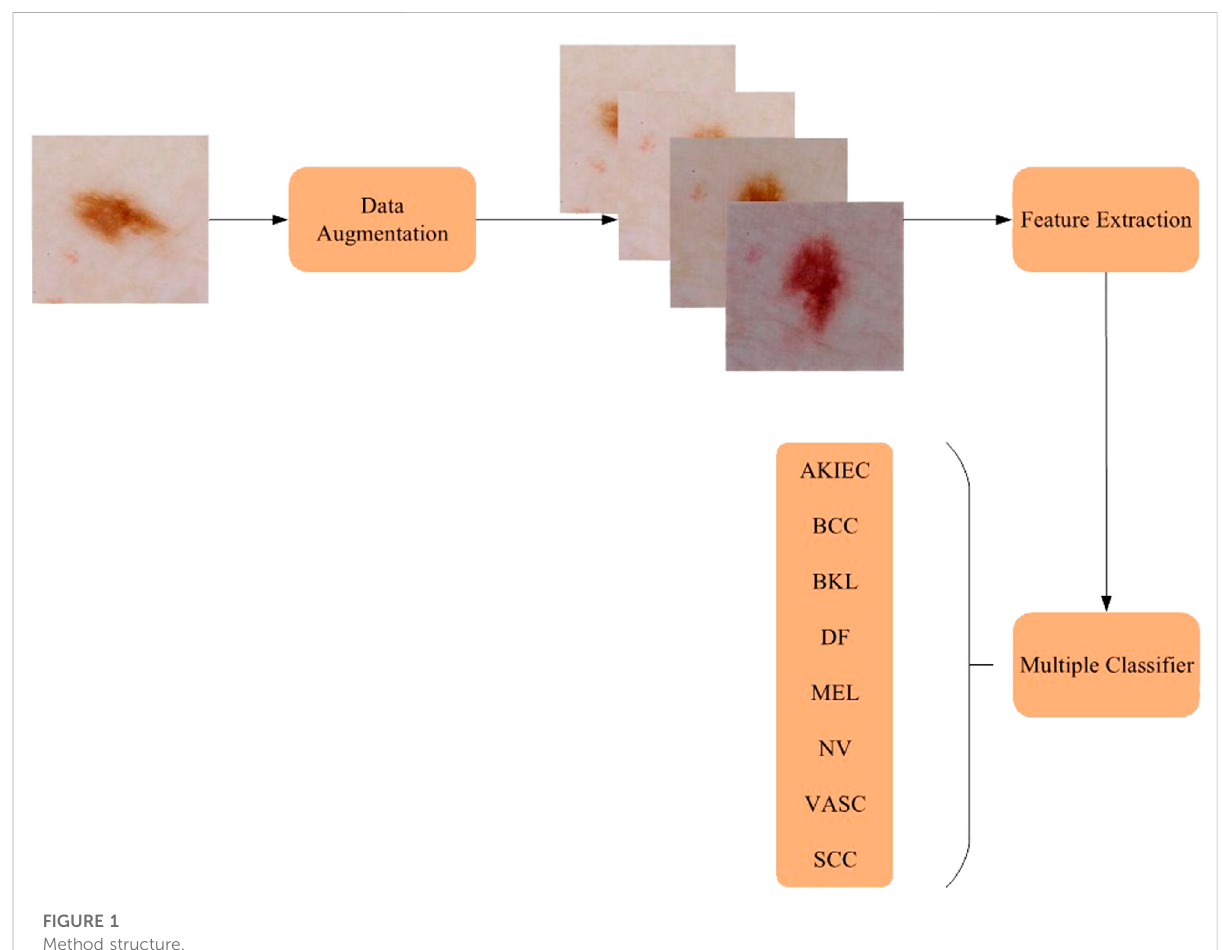
FIGURE 1 Method